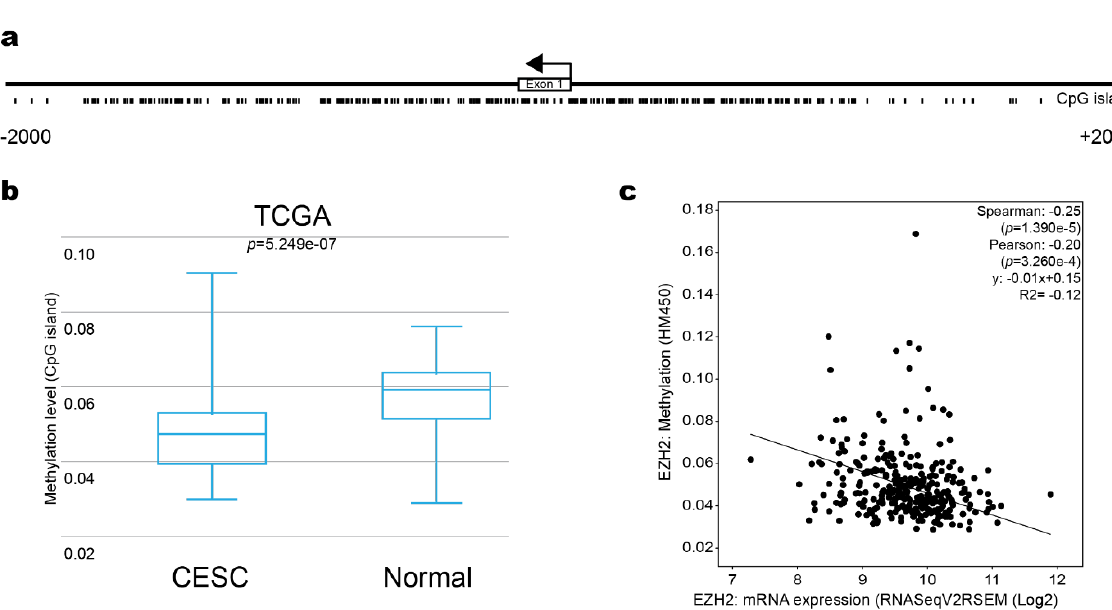
Figure 2: DNA hypomethylation in EZH2 promoter in cervical cancer. a) CpG islands at EZH2 pro- moters. The analyzed region corresponds to 2 kb around the TSS. b) Methylation level at EZH2 pro- moter in TCGA patients. Student's t -test, p -value =5.249e-07. c) Correlation between methylation levels and EZH2 expression in TCGA patients.